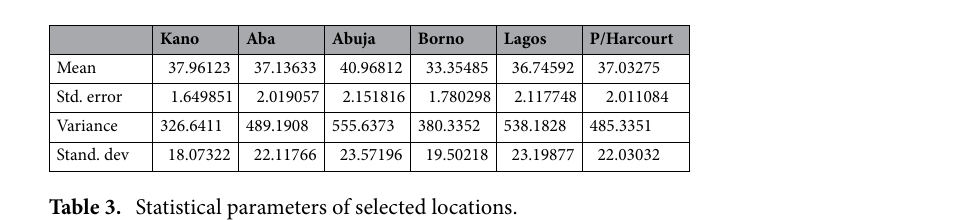
Table 3. Statistical parameters of selected